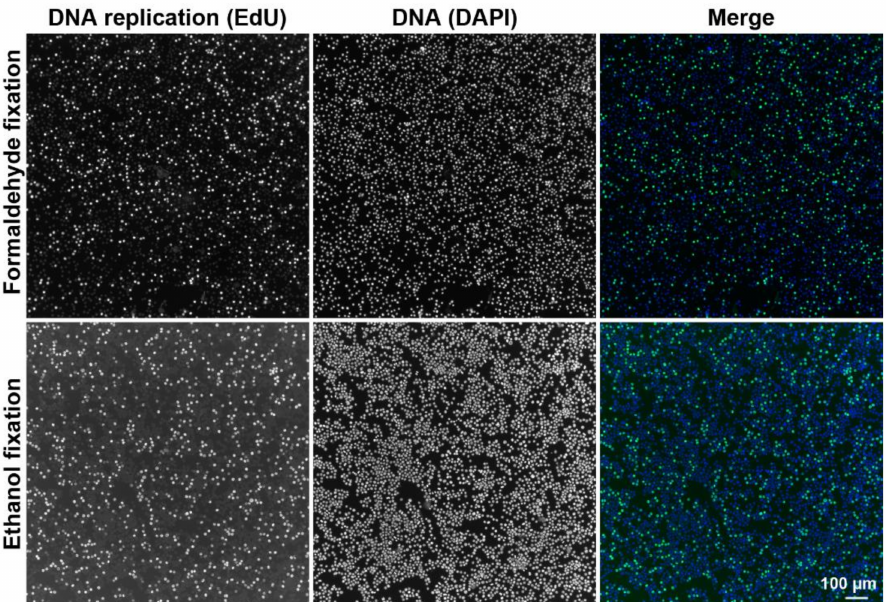
Figure 6. Example of the detection of DNA replication and DNA in HeLa S3 cells. The cells were labeled with EdU for 30 min and captured on glass coverslips. EdU was revealed by click reaction with 6-FAM azide (green) and the DNA was detected by DAPI (blue). The cells were processed either by wet centrifugation (formaldehyde fixation) or by dry centrifugation (ethanol fixation). Scale bar = 100 µ